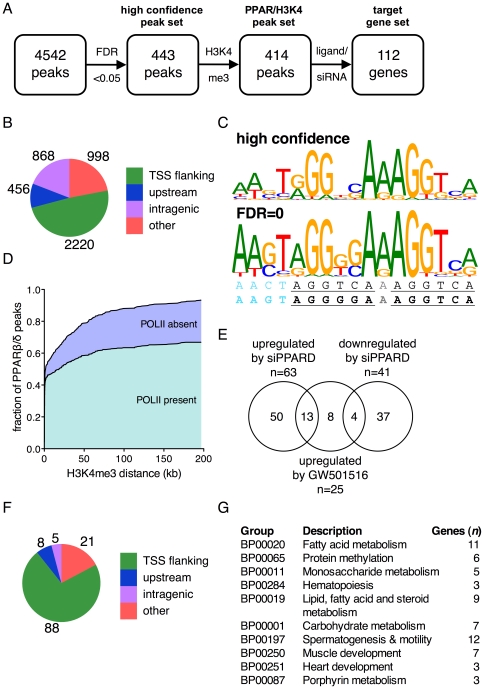
Genomewide identification of PPARβ/δ target genes by combining ChIP-Seq and transcriptional profiling.(A) Flow chart showing consecutive steps of bioinformatic analysis for the definition of high confidence PPARβ/δ-regulated genes (target gene set). These genes are characterized by one or more peaks with an FDR<0.05 that is/are located within 200 kb of a database-defined gene (Ensembl release 58), a cluster of H3K4me3 marks, RNA polymerase II enrichment and transcriptional responsiveness to PPARD siRNA and/or the agonist GW501516. (B) Distribution of genomewide PPARβ/δ binding for all 4,542 peaks identified by ChIP-Seq. TSS flanking is defined as regions from −5000 bp to the 3′ end of the first intron, upstream regions are located within −25 kb of a transcriptional start site (TSS). (C) Consensus sequence identified by de novo motif search (MEME) [25] of ChIP-Seq in high confidence (top) and FDR = 0 peaks (bottom). The line beneath shows the published consensus sequence [27]; the bottom line (boldface) shows the refined sequence derived from the present study. (D) Overlap between high confidence PPARβ/δ peaks, H3K4me3 marks and RNA polymerase II enrichment detected by parallel ChIP-Seq experiments. (E) Venn diagram showing the overlap between genes regulated by PPARD siRNA or activated by GW501516. (F) Analysis of PPARβ/δ peak distribution for the target gene set. (G) Panther biological process (BP) classification of the target gene set. The 10 most enriched BP terms describing biological processes affected by PPARβ/δ are shown.